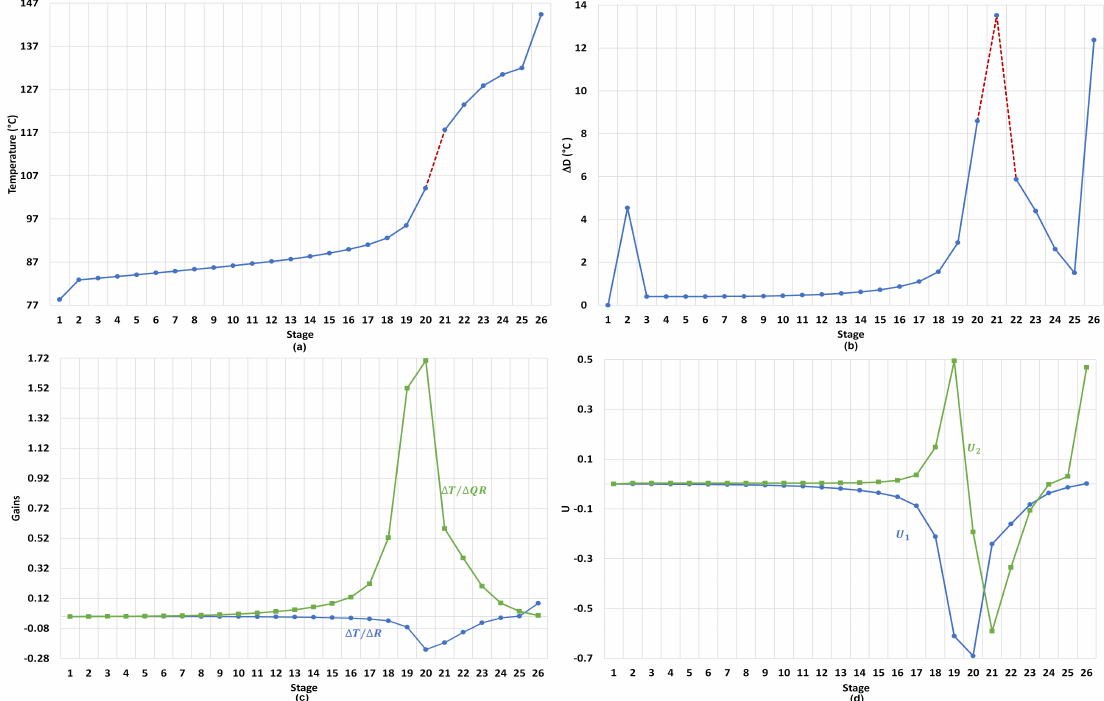
Figure 7. Sensor location for temperature control ( a ) temperature profile; ( b ) temperature change stage to stage; ( c ) sensitivity analysis gains; and ( d ) left singular vectors U 1 and U 2 calculated from the singular value decomposition (SVD) analysis vs. stage